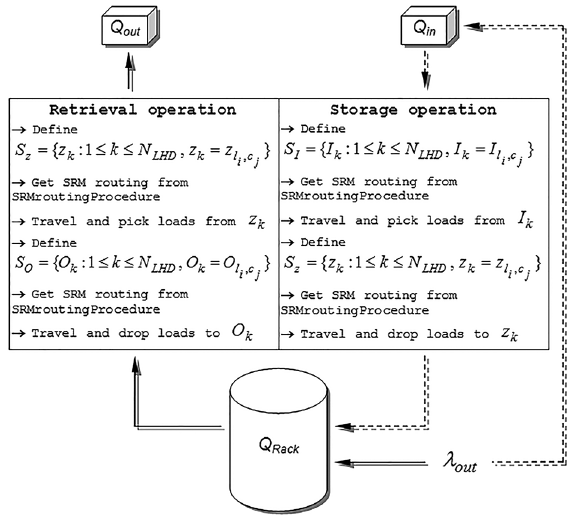
Fig. 6. C-AS/RS simulation model flow